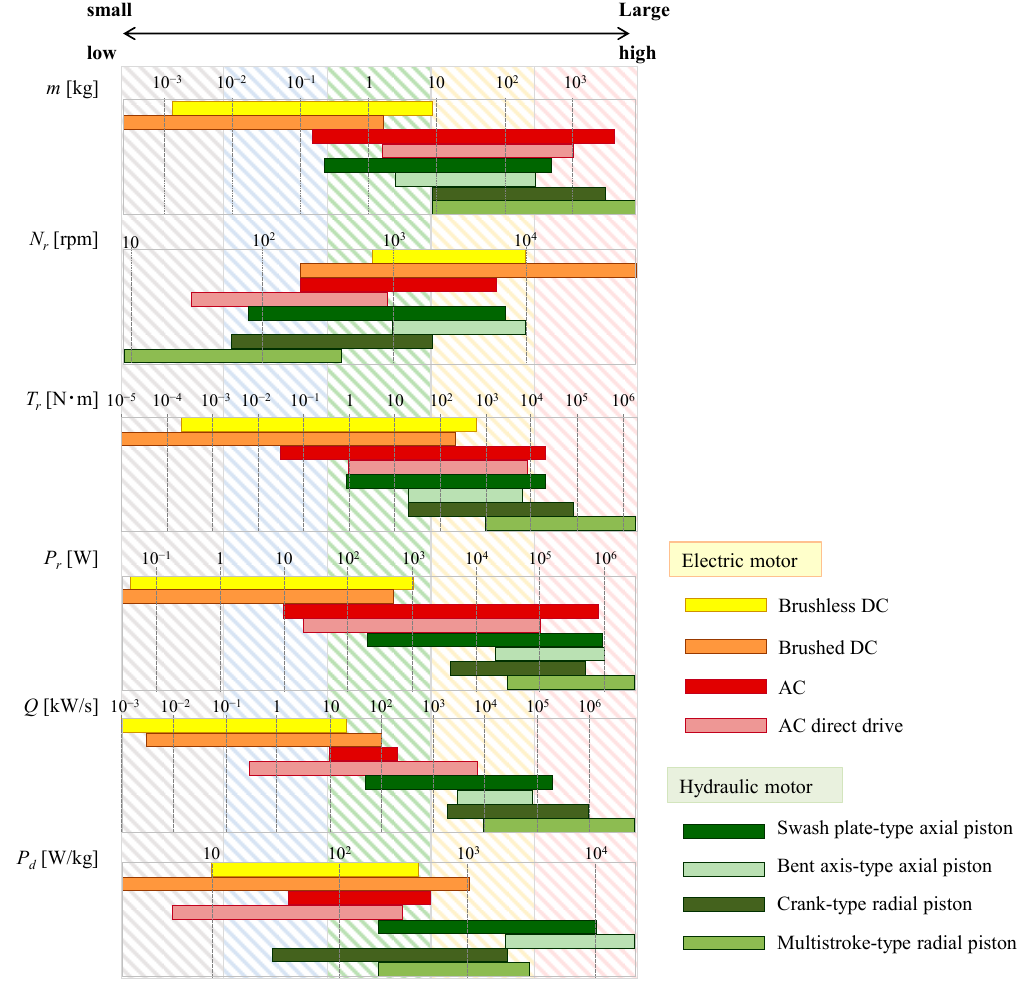
Figure 16. Summary of motor characteristics.